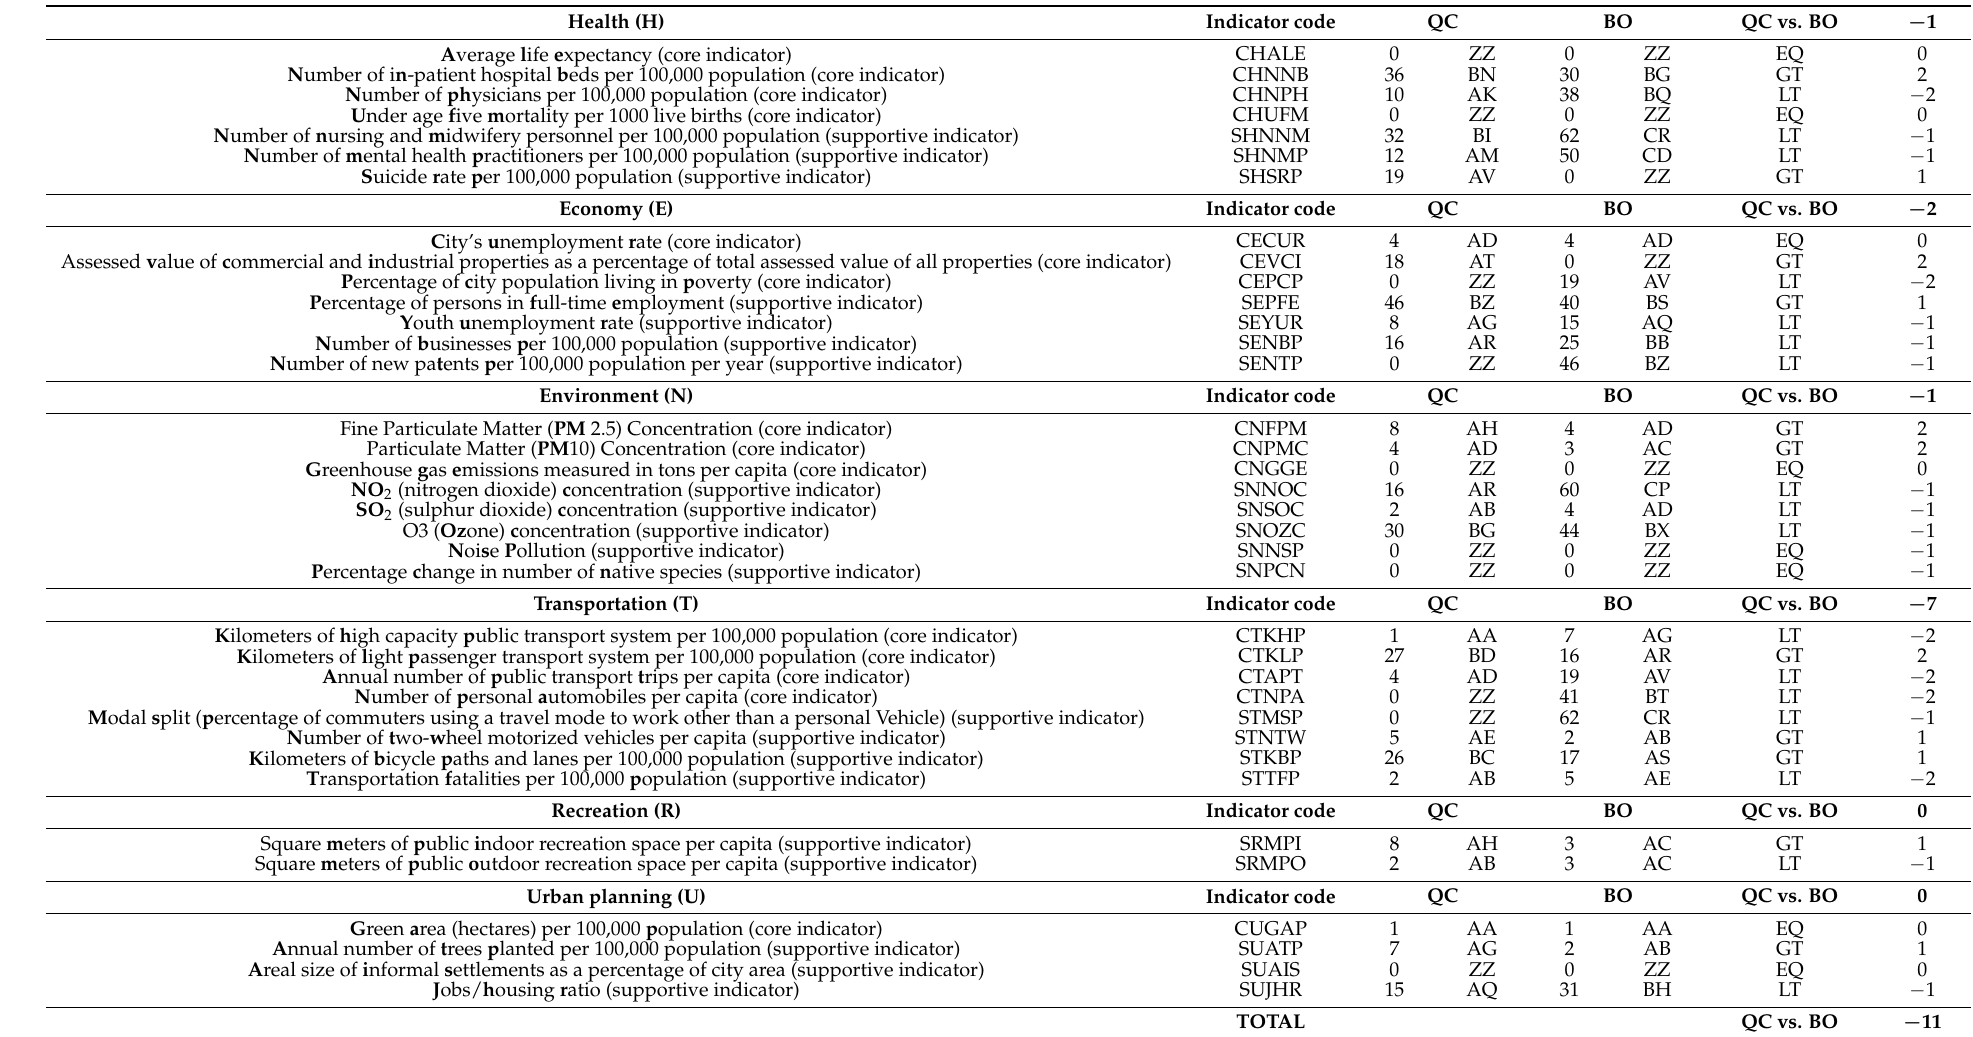
Table 3. Coded indicators, their numerical and coded values, and results of applying algorithm 1 on (Quebec City (QC) vs. Boston (BO)) data. Health